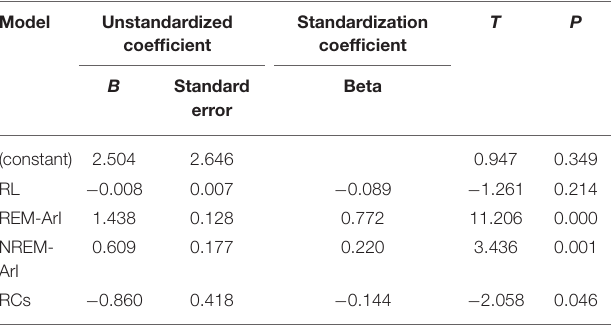
TABLE 6 | Predictive regression model coefficients of depression risk in patients with short-term